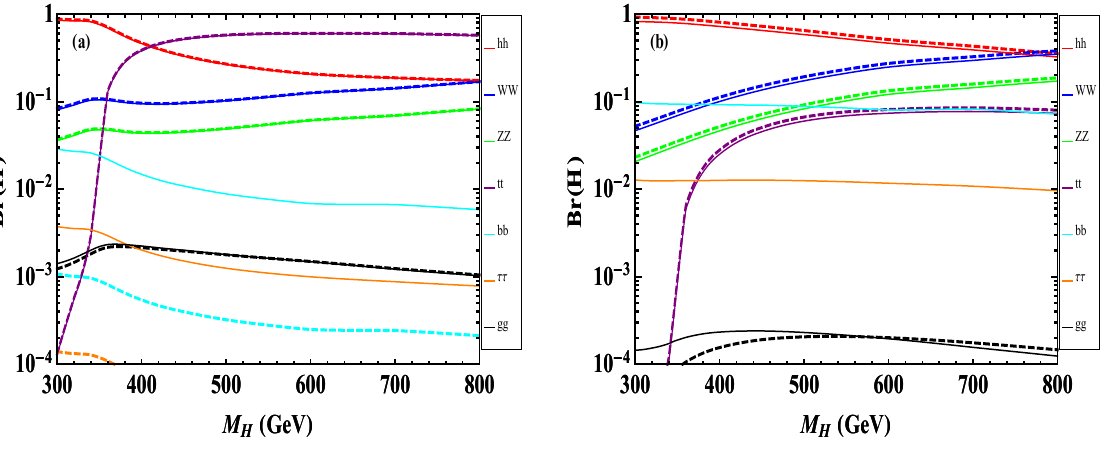
Figure 3 . Decay branching fractions of the heavy Higgs boson H 0 as functions of its mass M tan (cid:12) = 2 [plot-(a)] and tan (cid:12) = 5 [plot-(b)]. where we set ( M and cos( (cid:12) (cid:0) (cid:11) ) = 0 : 1 for illustration. The dashed (solid) curves represent the results of 2HDM-I (2HDM-II) in each